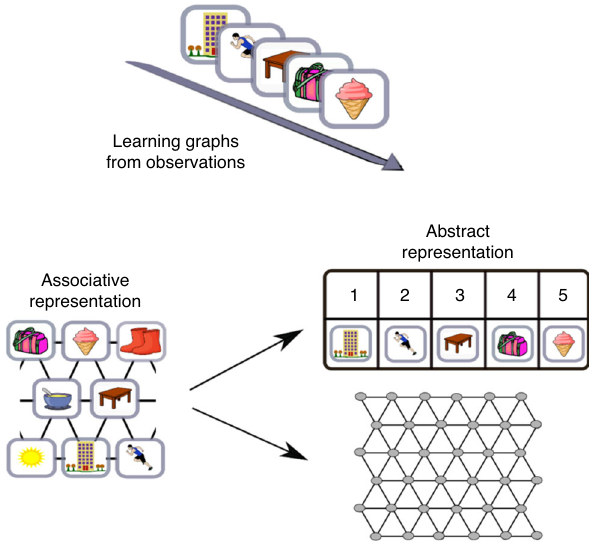
Fig. 2 Associative and abstract representation of transition structure. Learning underlying graph structure from observations of pictures. Graph can be represented by learning the associations between the stimuli (associative representation). Such representation is conjunctive, as the relations between the stimuli are encoded using the associations between the representation of the stimuli themselves. This type of representation does not allow generalization and knowledge transfer. Representing the graph using two separate matrices, the transition and emission matrices allows generalization over graph structure.